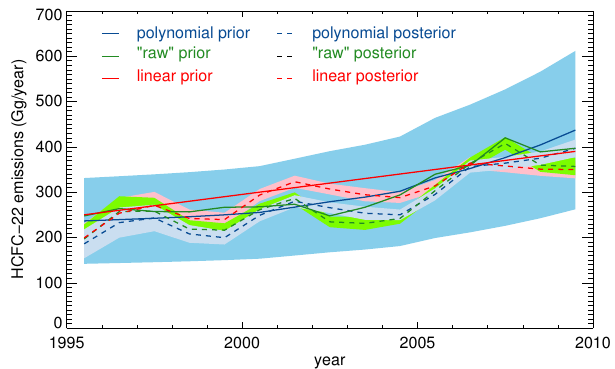
Fig. 4. Global total prior (solid lines) and posterior (dash lines) HCFC-22 emissions using the following three sets of a priori emissions: polynomial fit prior (blue), “raw” prior (green), and linear fit prior (red).